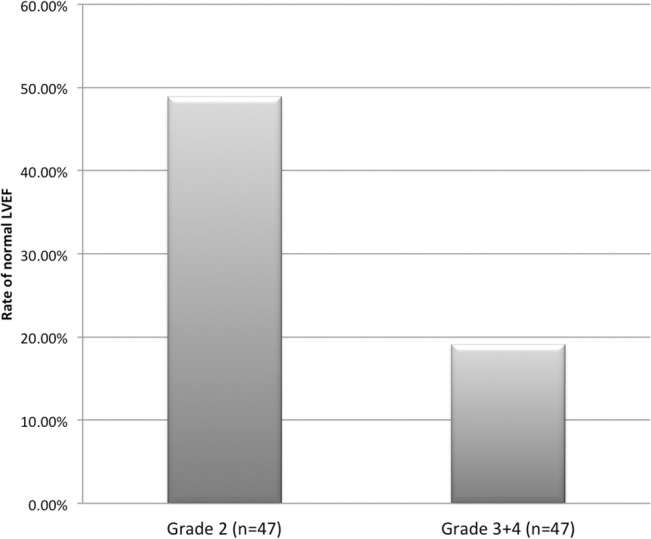
Echocardiographic follow-up at 90 days.Nearly half of the Grade-2 patients had LVEF recovered to normal (≥55%), while much fewer patients had improved LVEF in both Grade-3 and Grade-4 groups.